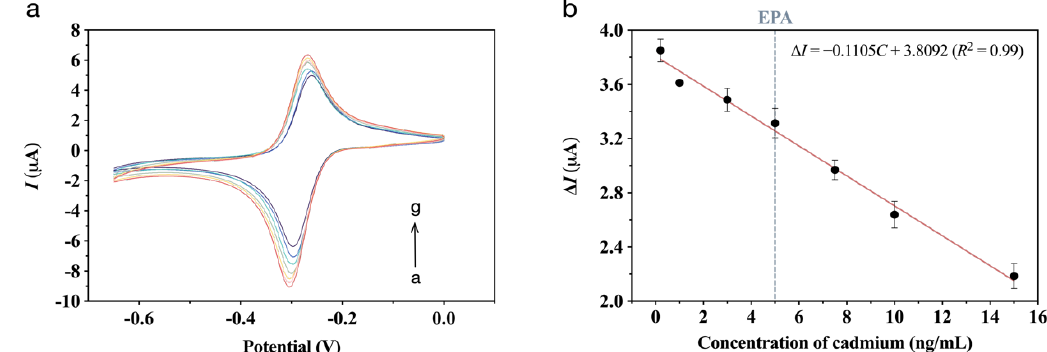
Figure 4. ( a ) CV responses to aptasensor upon various concentrations of Cd 2 + from a to g: (a) 0.2, (b) 1.0, (c) 3.0, (d) 5.0, (e) 7.5, (f) 10.0, (g) 15.0 ng/mL in detection buffer (pH = 5.5); ( b ) Calibration plots of ∆ I versus concentration of Cd 2 + .